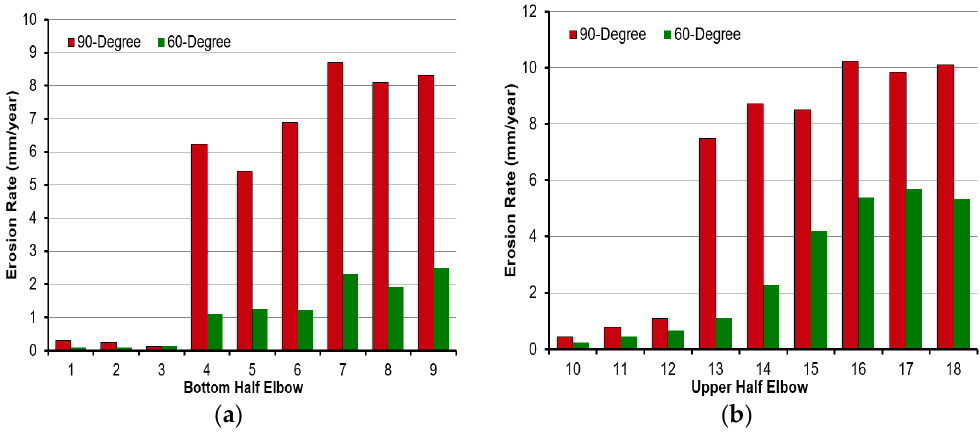
Figure 13. Mass loss in carbon steel elbow section after test: ( a ) bottom; ( b ) top.